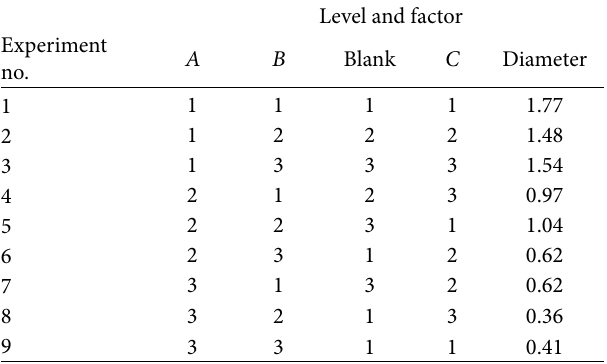
Table 4: Result of the orthogonal experiment.